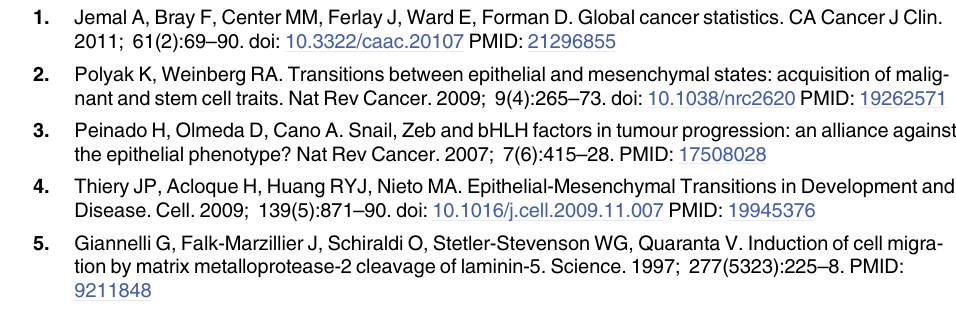
S1 Fig. Representative immune-staining of EMT-related proteins in different cancers as positive controls. SNAI1/2 in breast cancer (a), ZEB2 in colorectal cancer (b), ZEB1 in colo- rectal cancer (c), TWIST1 in cervical cancer (d), CDH1 in breast cancer (e), LAMC2 in breast cancer (f), ZEB1 in breast cancer (g) and ZEB1 in ovarian cancer (h) (Original magnification: 400X). S2 Fig. Representative Immunostaining of EMT-related proteins in TMA cores and respec- tive whole tissue section for concordance evaluation (Original magnification: 400X). S3 Fig. Kaplan Meier survival analyses of ZEB2 and TWIST1. Near significant association of expression of ZEB2 (a) and TWIST1 (b) with poor patient ’ s overall survival. S1 Table. Immunohistochemical staining protocol and evaluation for antibody against EMT-related proteins. S2 Table. Sample size calculation. S3 Table. Correlation between CDH1 expression with expression of EMT transcription fac- tors. S4 Table. Association between expression of EMT-related proteins with overall survival.